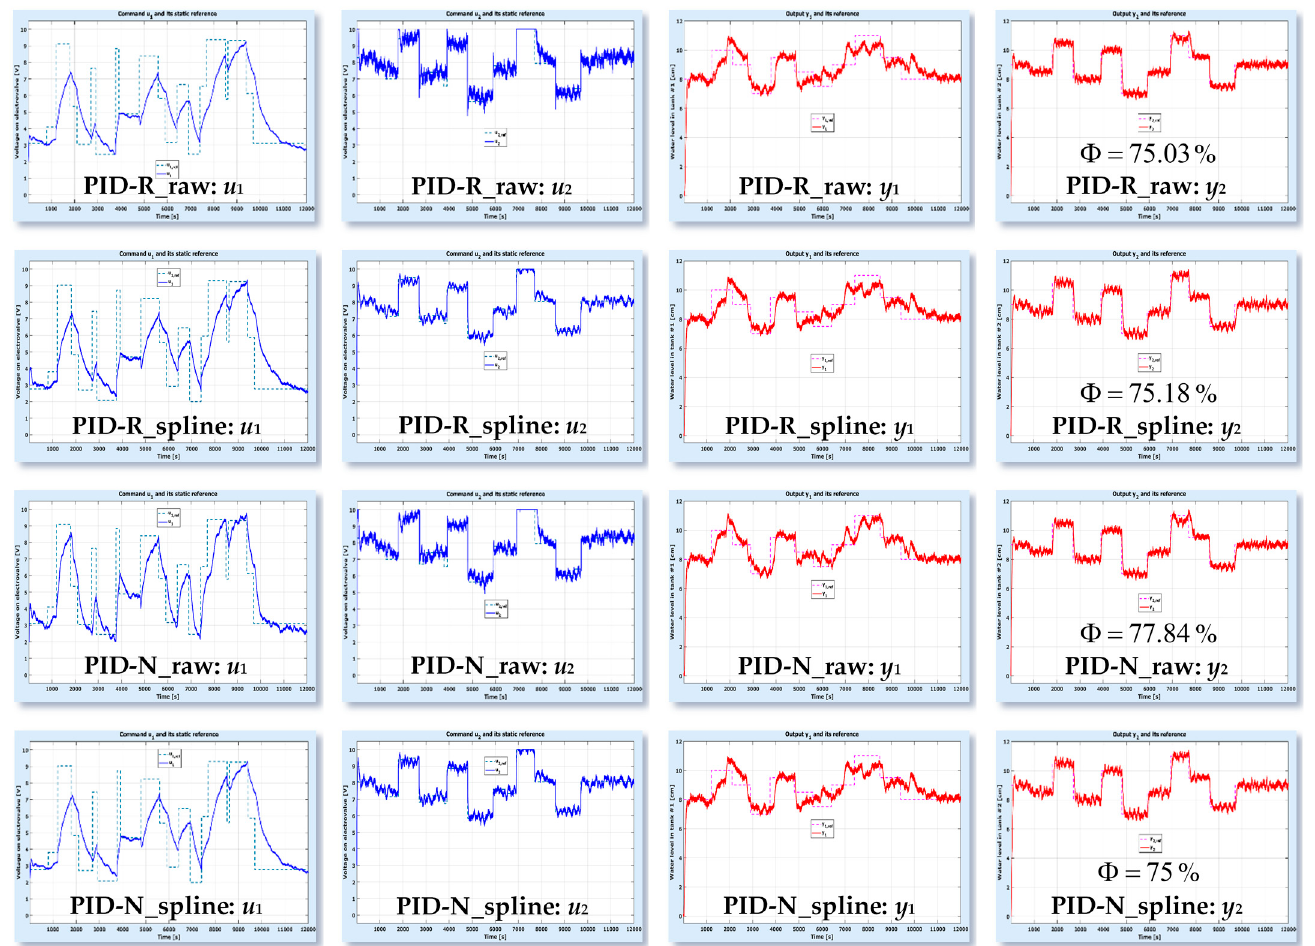
Figure 20. PID-ASTANK2 performance for a configuration of staircase references.